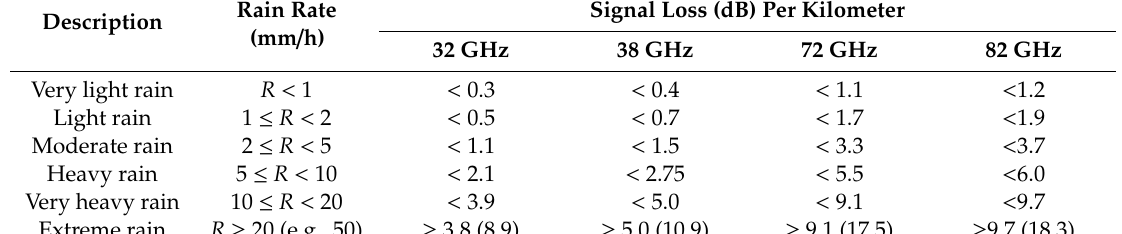
Table 2. Signal loss due to rain (dB / km).